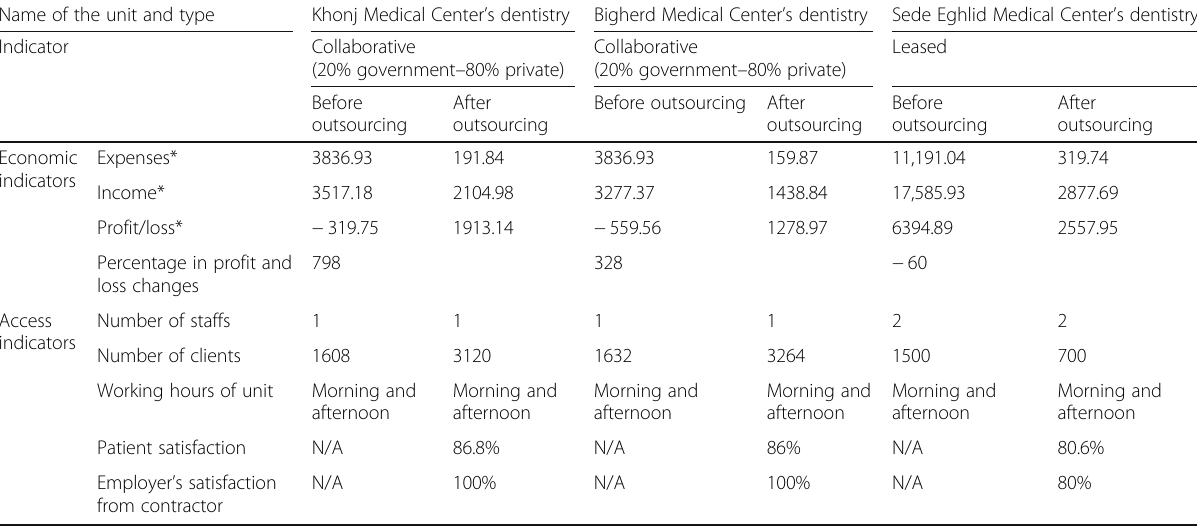
Table 4 Comparison of the dentistry unit ’ s performance in Shiraz University of Medical Sciences before and after the outsourcing process, Iran, 2010 – 2012 Name of the unit and